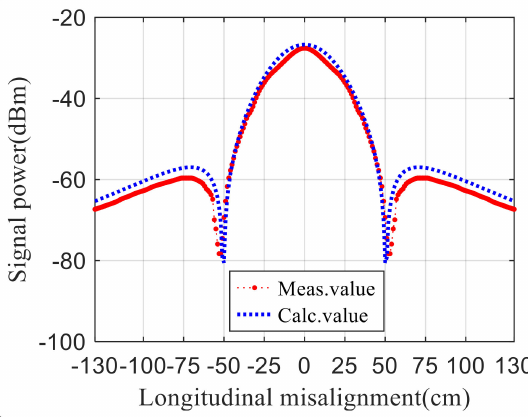
Figure 15. Validation results of the uplink field conformity